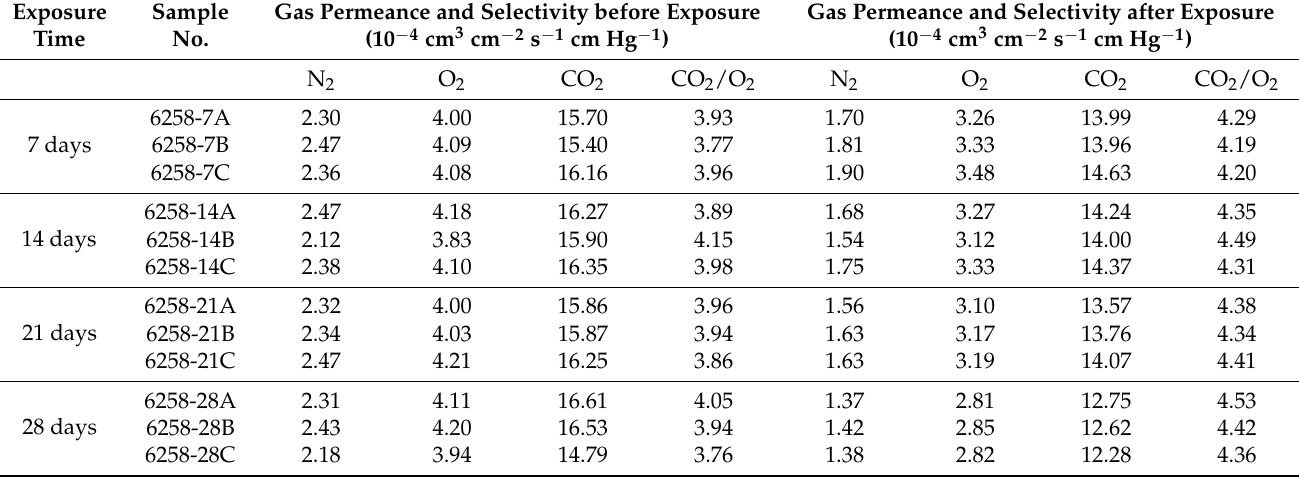
Table 15. Change of gas permeability characteristics of TMCTS plasma polymer coated X30-240 fiber on exposure to 0.9% buffered saline.